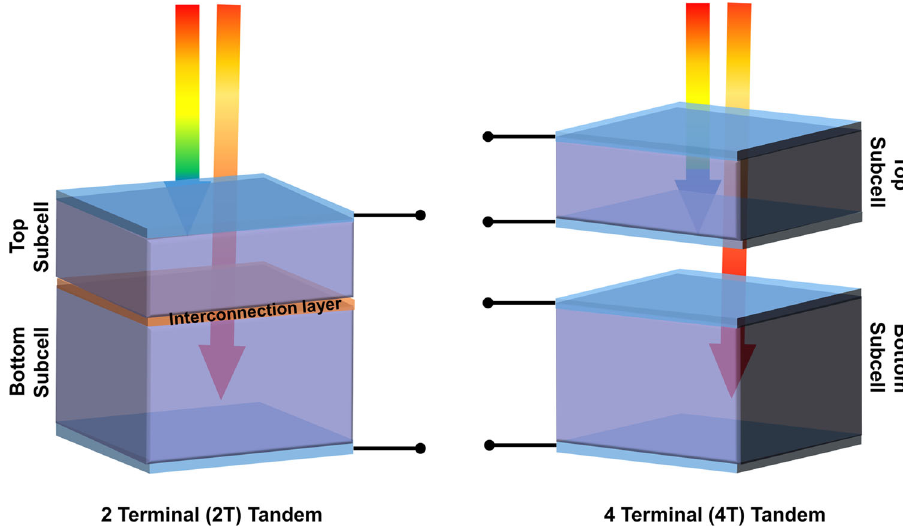
Fig. 2 Structures of the two most common tandem architectures. The fi gure shows two-terminal and four-terminal device con fi gurations. It should be noted that in the literature, the positions of the top and bottom subcells are de fi ned differently. In this Review, we de fi ne the top subcell as the cell in which the light initially passes through to the bottom